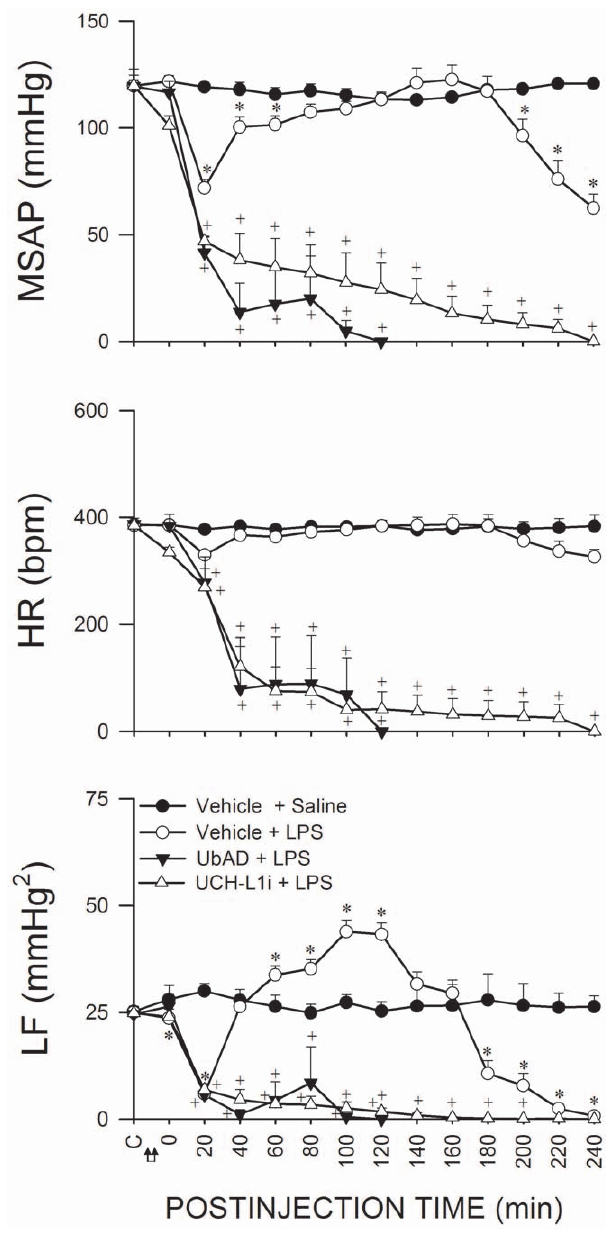
Figure 6. De-ubiquitination is crucially involved in maintaining brain stem cardiovascular regulation during experimental brain death. Temporal changes in MSAP, HR or power density of the LF component of SAP signals in rats that received pretreatment by microinjection bilaterally into RVLM of ubiquitin aldehyde (UbAd), UCH- L1 inhibitor (UCH-L1i) or their solvents (Vehicle), followed by IV administration (at arrows) of LPS (15 mg kg 2 1 ) or saline. Values are mean 6 SEM; n=7–8 animals per group. * P , 0.05 versus Vehicle + Sa- line group, and + P , 0.05 versus Vehicle + LPS group at corresponding time-points in the Scheffe´ multiple-range test. C,